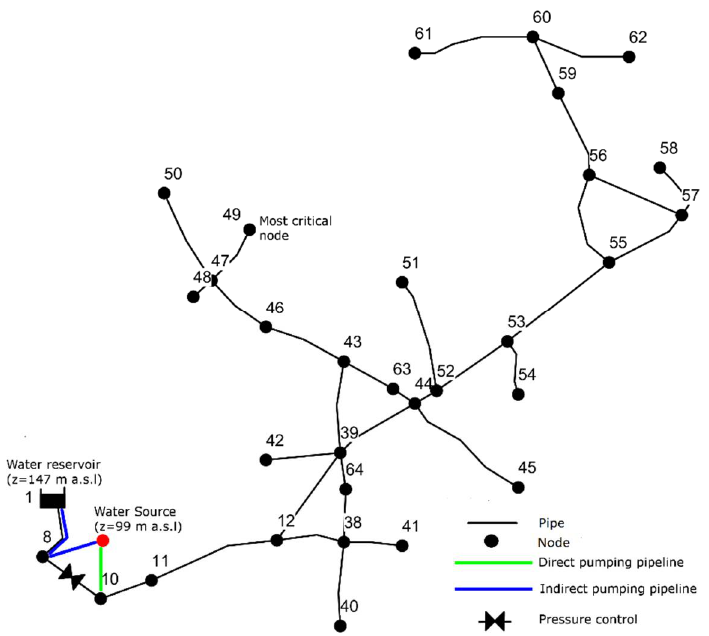
Figure 1. Hydraulic network of the study area.